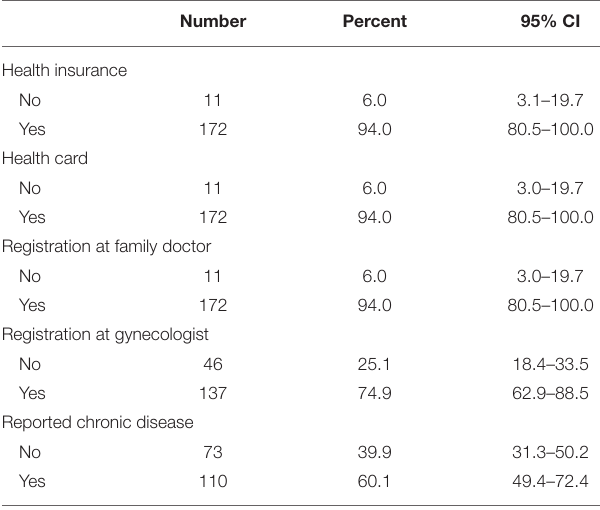
TABLE 2 | Health insurance status and registration with health